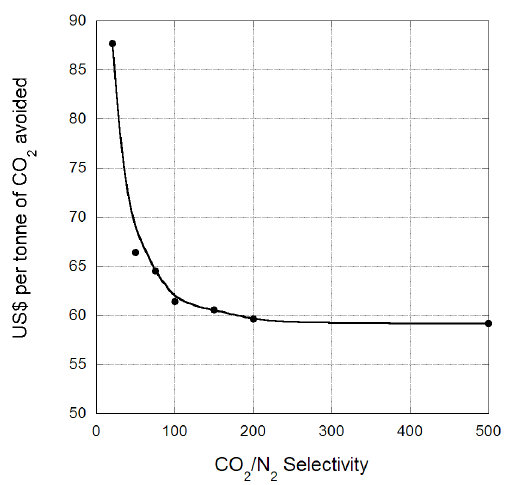
Figure 7. Cost of capture (US$ per tonne of CO 2 avoided) for NGCC as a function of membrane CO 2 /N 2 selectivity, with no blower.